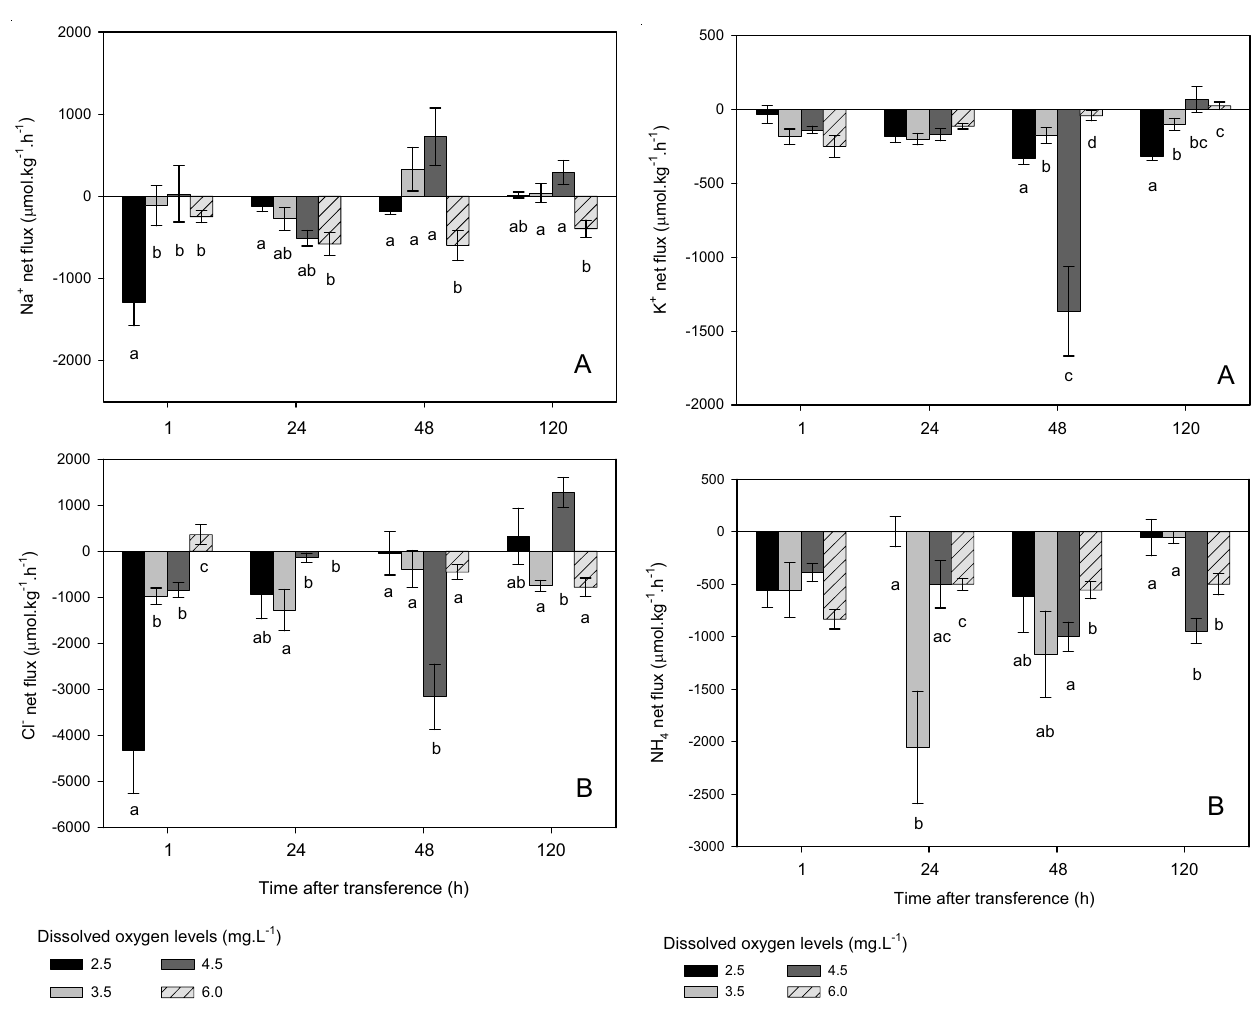
Fig. 2. K + (A) and NH 4+ (B) net fluxes of silver catfish juve- niles acclimated at 6.0 mg.L -1 dissolved oxygen levels and transferred to aquaria with different oxygen dissolved levels. Data expressed as mean ± SEM. Positive values indicate net influxes, and negative values net effluxes. Different letters under the bars indicate significant difference among treat- ments at the same time after transference by one-way ANOVA and Tukey test (NH 4+ ) or by Kruskall-Wallis Anova and Mann-Whitney test (K + ) (P <